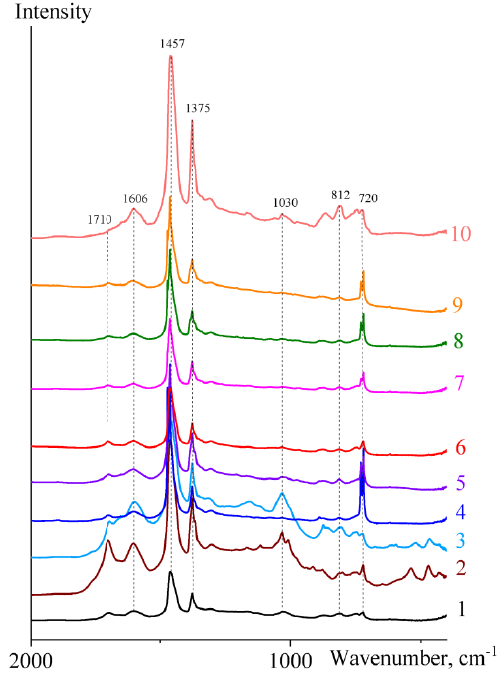
Figure 2. IR spectra of bitumens, whose numbers are indicated in Table 1. Table 2. Spectral characteristics of bitumens presented in Table 1.